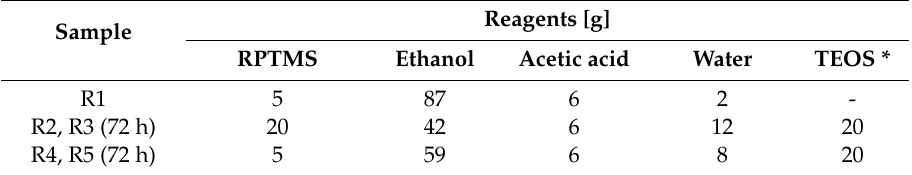
Table 1. Amounts of reagents used for the preparation of silane solutions.